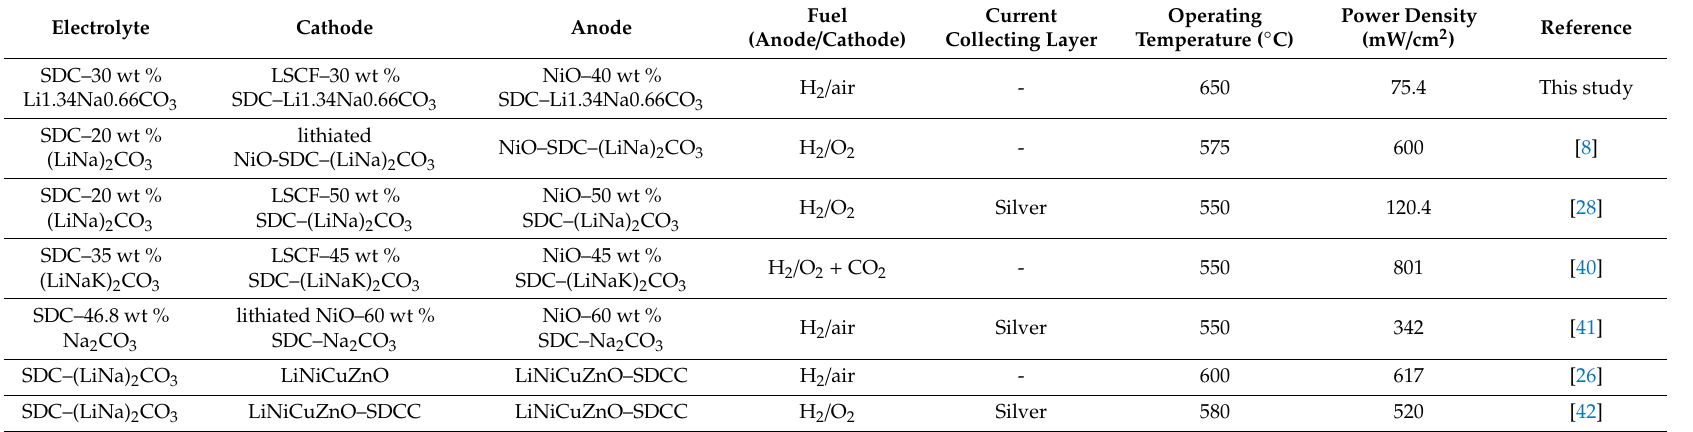
Table 2. Comparison of single-cell performance based on doped ceria–carbonate composite electrolyte